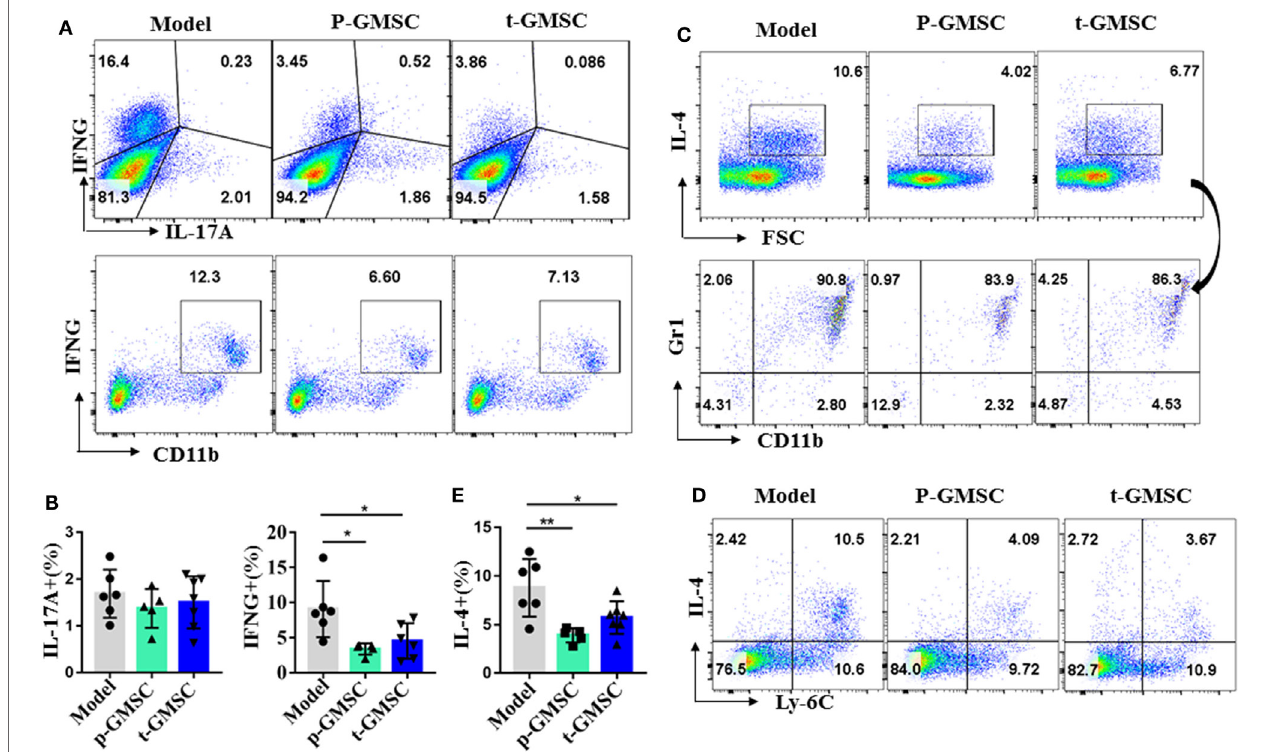
FigUre 3 | Effects of human gingiva-derived mesenchymal stem cells (GMSC) on the secretion of inflammatory cytokines in ApoE − / − mice. Fresh spleen cells from ApoE − / − mice were isolated and stimulated with phorbol 12-myristate 13-acetate (0.05 μ g/ml) and ionomycin (0.5 μ g/ml) for 1 h followed by blocking cytokines secretion with brefeldin A (1 × ) for 4 h. Anti-CD11b, Ly-6C, Gr1, and cytokines, such as IL-17A, TNF- α , IFN- γ , and so on were stained and analyzed with flow cytometry. (a) Representative dot plots of IL-17A, IFN- γ , and CD11b + IFN- γ + expressing in spleen cells were depicted. (c,D) Representative dot plots of Ly-6C + IL-4 + and the subset of Gr1 + CD11b + in IL-4 + cells in spleen cells were depicted. (B,e) Bar graphs show the mean ± SD (model, n = 6; p-GMSC, n = 5; t-GMSC, n = 7). * p < 0.05; ** p <